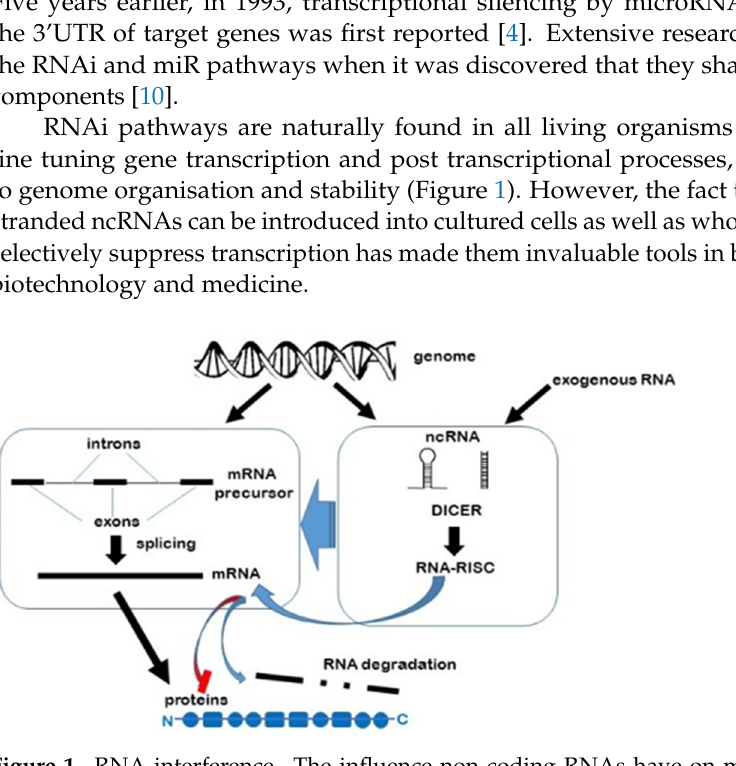
Figure 1. RNA interference. The influence non-coding RNAs have on mRNA once it has been transcribed from its gene on its journey to the ribosome for translation into protein.